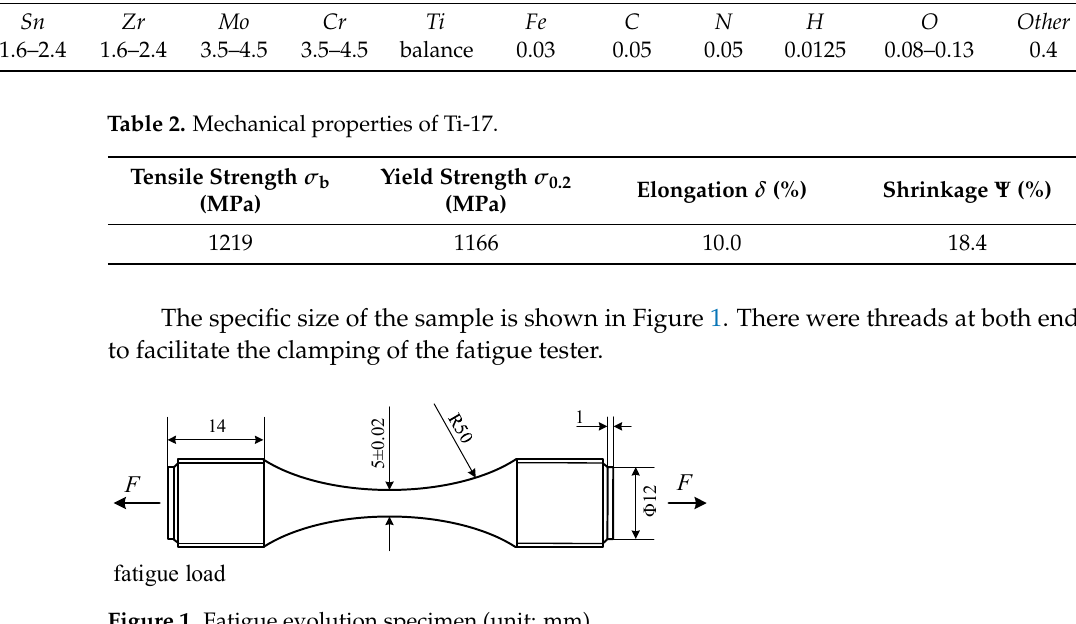
Figure 1. Fatigue evolution specimen (unit: mm).